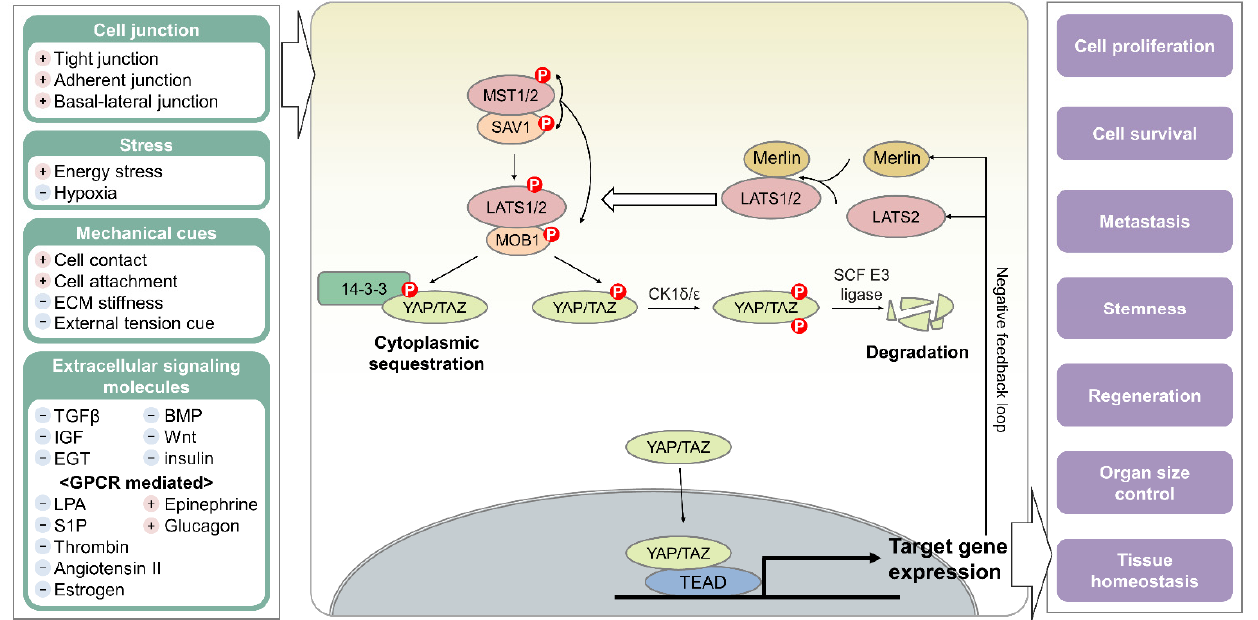
Figure 1. Schematic representation of the mammalian Hippo pathway. The Hippo kinase cascade, composed of Ser/Thr kinases MST1/2 and LATS1/2, adaptor proteins SAV1 and MOB1, and effectors YAP/TAZ, is regulated by various stimuli, including cell–cell junctions, cellular stresses, mechanical cues, and multiple extracellular signaling molecules. A “+” indicates a stimulus that increases the activity of the Hippo pathway, and a “ − ” indicates a stimulus that decreases activity. The Hippo pathway phosphorylates YAP/TAZ, leading to their cytoplasmic sequestration and proteasomal degradation. Dephosphorylated YAP/TAZ translocate into the nucleus and act as transcriptional cofactors, thereby controlling cellular responses such as proliferation, survival, and metastasis and affecting stemness, regeneration, organ size, and tissue homeostasis.